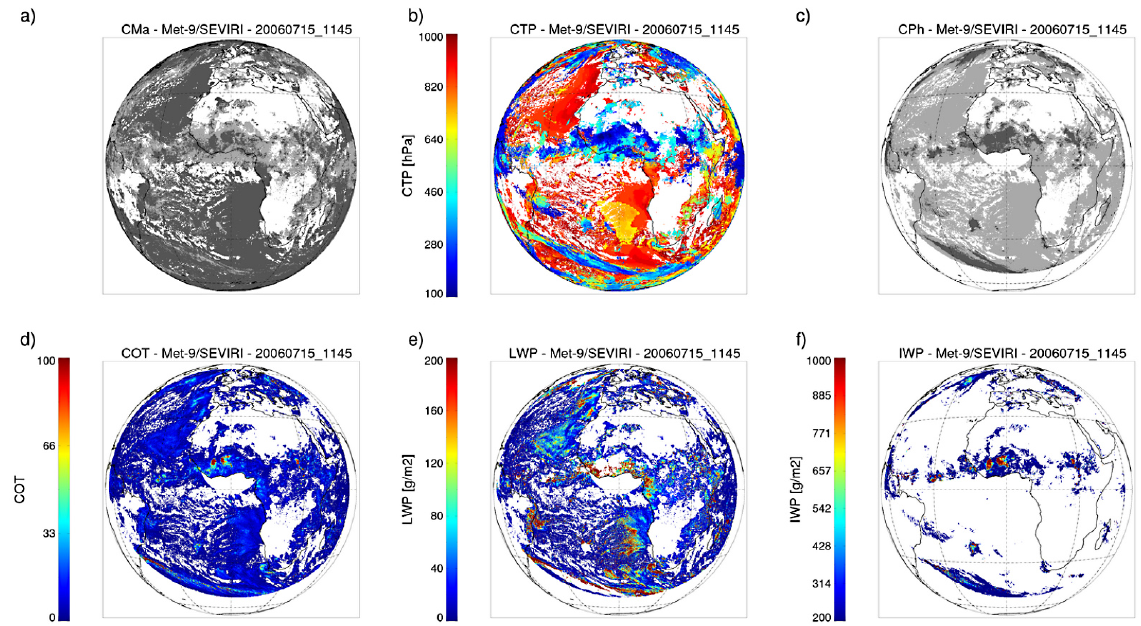
Fig. 2. Examples of pixel-based CLAAS products for (a) cloud mask (CMa), (b) cloud top pressure (CTP), (c) cloud thermodynamic phase (CPh), (d) cloud optical thickness (COT), (e) liquid water path (LWP), and (f) ice water path (IWP). For the cloud mask plot, dark grey is cloud filled and light grey cloud contaminated. For cloud phase, light grey stands for liquid clouds and dark grey for ice clouds. While CMa and CTP products are processed at the full SEVIRI field of view, the retrieved optical properties REF and COT (and therefrom derived products CPh, LWP, IWP) are restricted to satellite zenith angles smaller than 72 ◦ . Water surface regions contaminated with sunglint are also omitted. All products are on native SEVIRI projection and resolution and shown for 15 July 2006 at